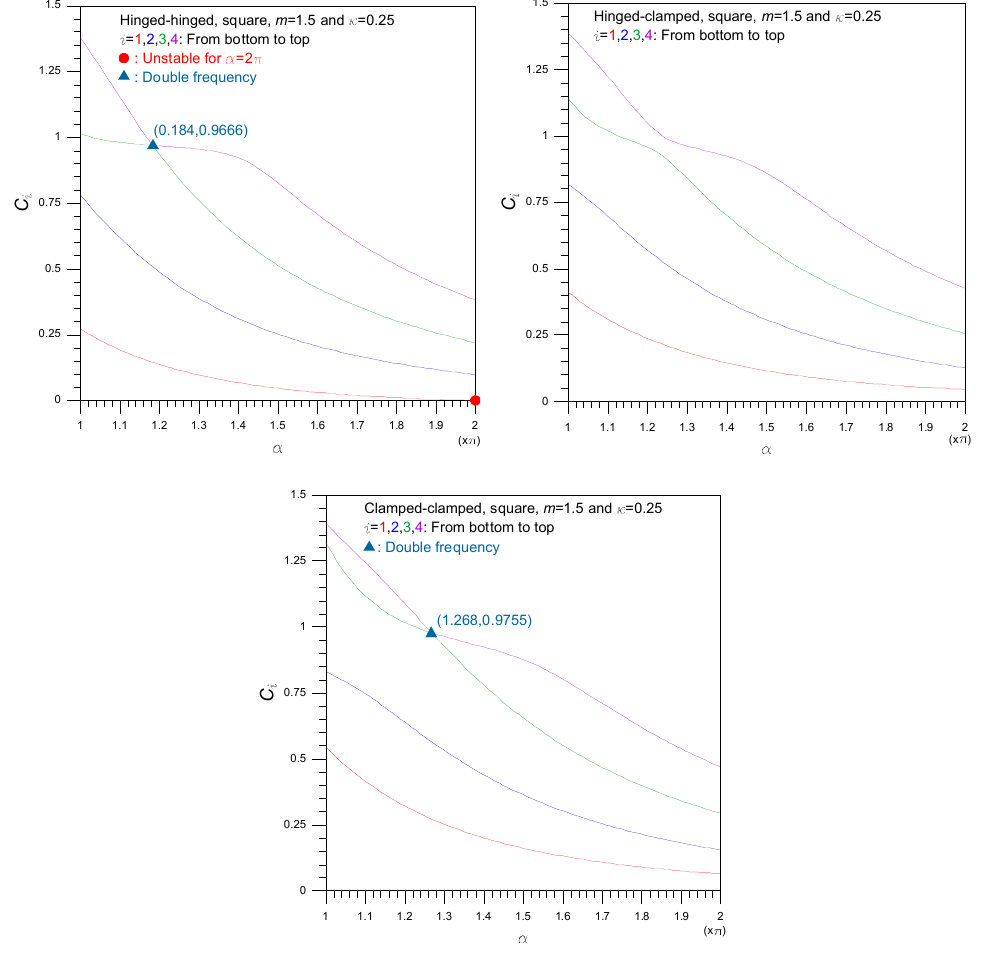
Figure 6. C i versus α